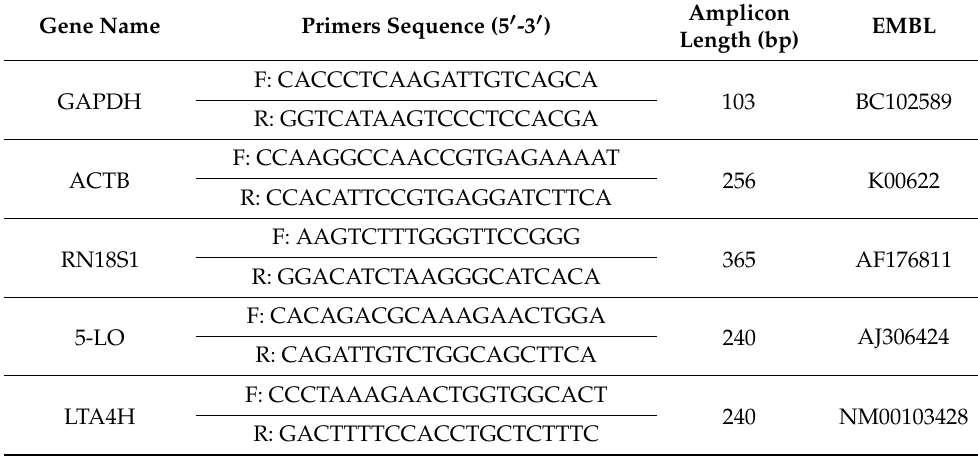
Table 1. List of monoclonal antibodies used for labeling lymphocytes for flow